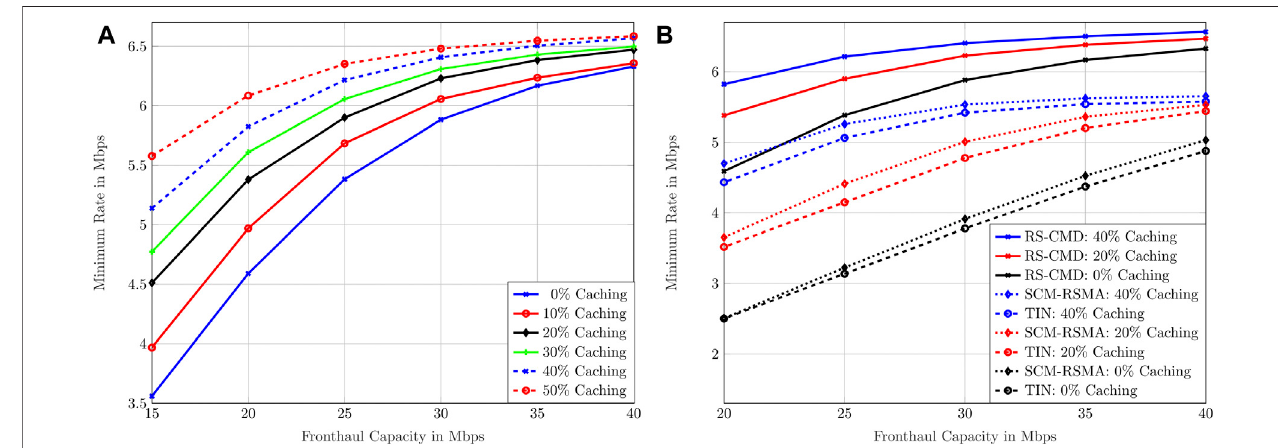
FIGURE 4 | MMF rate as a function of the fronthaul capacity for the statistical CSIT case. We consider the impact of different cache sizes. (A) considers RS-CMD only. (B) depicts a comparison between the schemes.